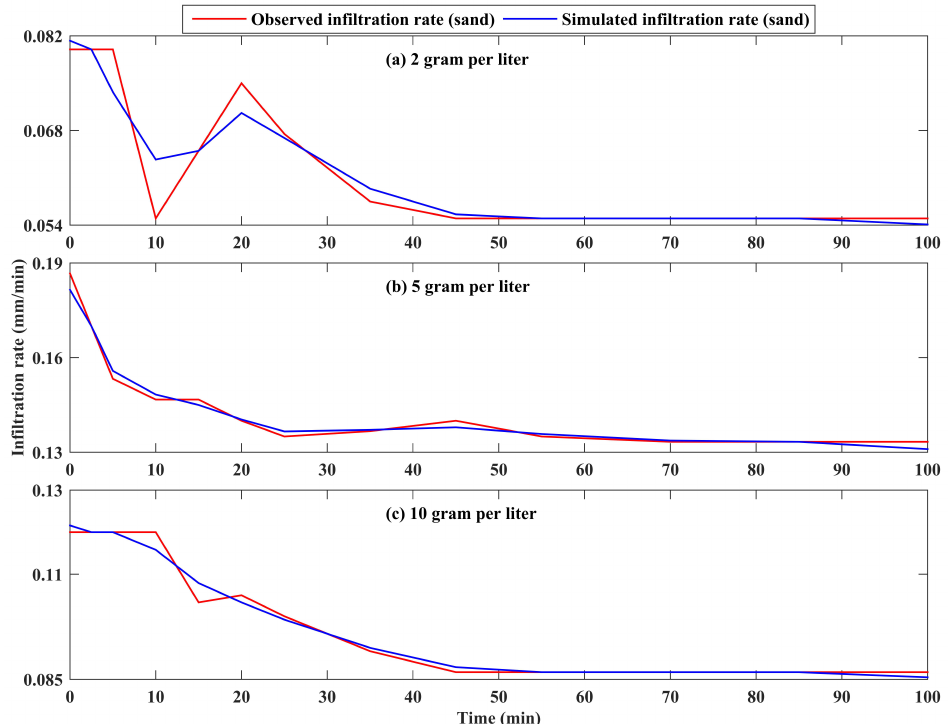
Figure 7. Comparison of the infiltration rate observed for the clean water (0 g/L) with that of the reconstructed using SSA for clay-sized suspended solids under three concentration levels 2, 5 and 10